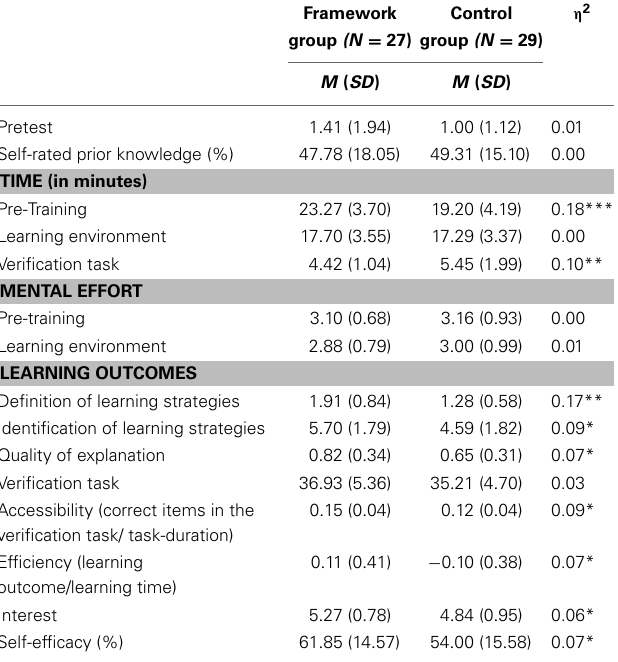
Table 1 | Means (and standard deviations) of learning outcome measures